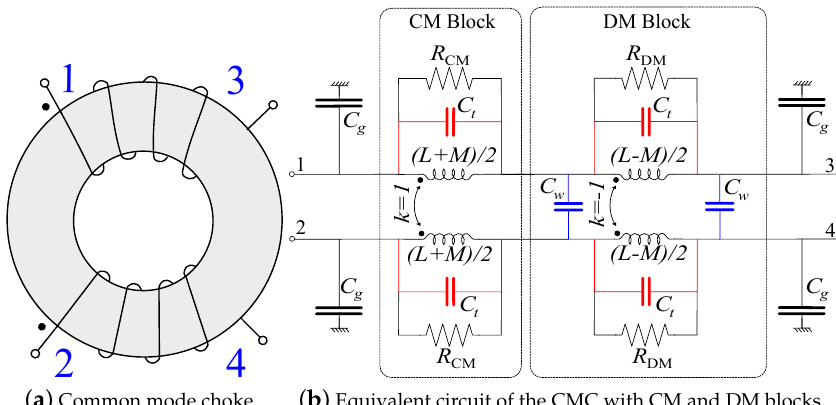
Figure 1. Representation and circuit model of a common mode choke made up of two equal coupled windings with self-inductance L and mutual inductance M